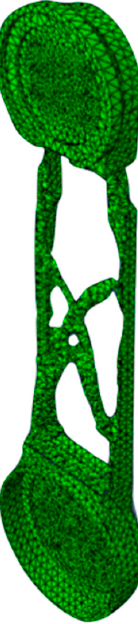
Figure 17. Failure topological